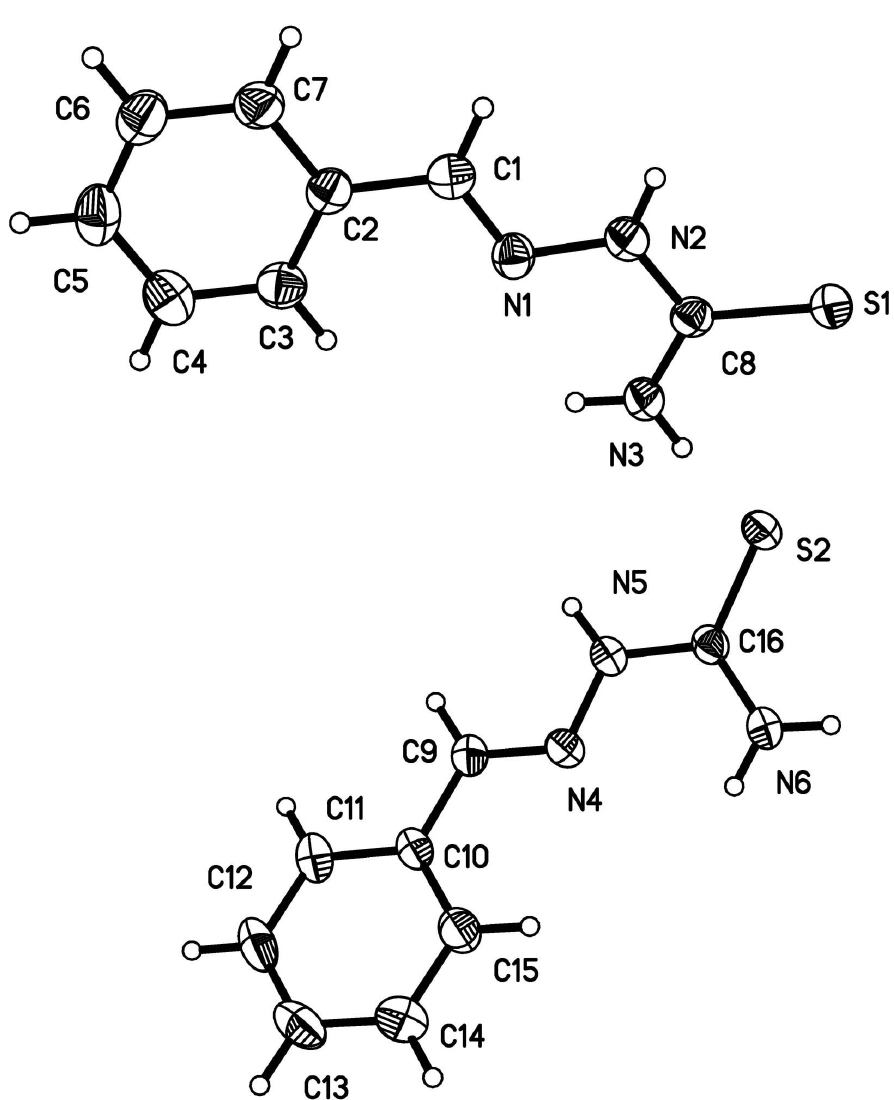
Two molecules in the asymmetric unit of the title compound with displacement ellipsoids shown at 30% probability for non-H